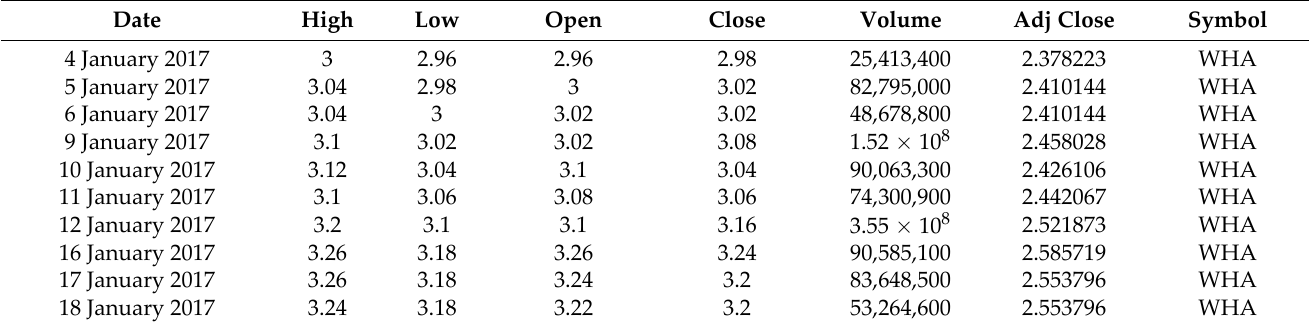
Table 1. Examples of securities information of WHA Corporation Public Company Limited